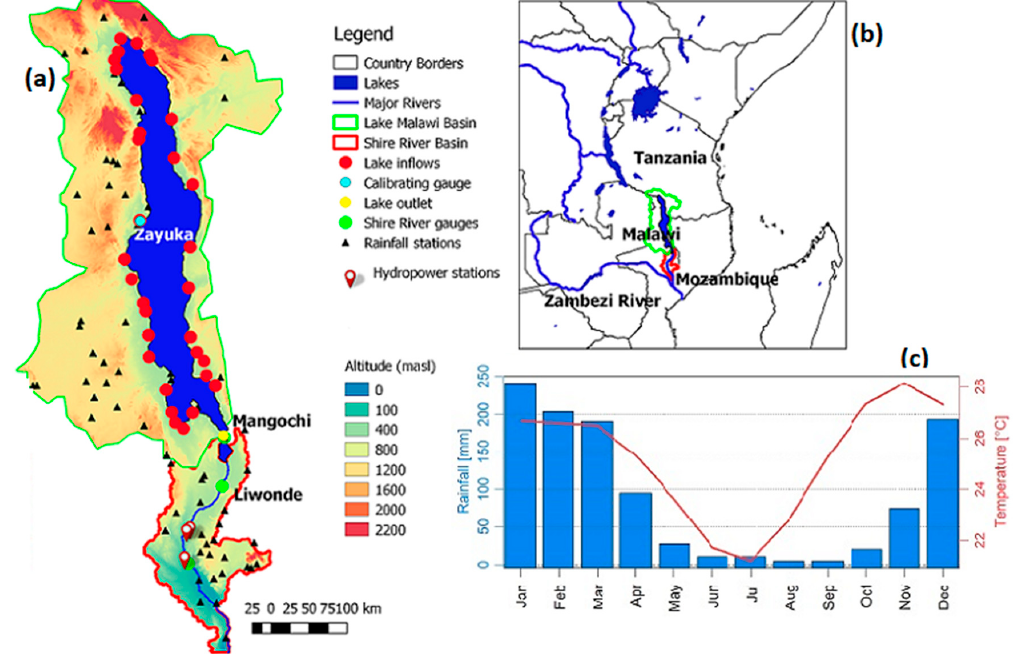
Figure 1. ( a ) The Lake Malawi and Shire River Basins, ( b ) their location in the Great Rift Valley in southeastern Africa and ( c ) the mean annual cycles of precipitation and temperature in the study area.